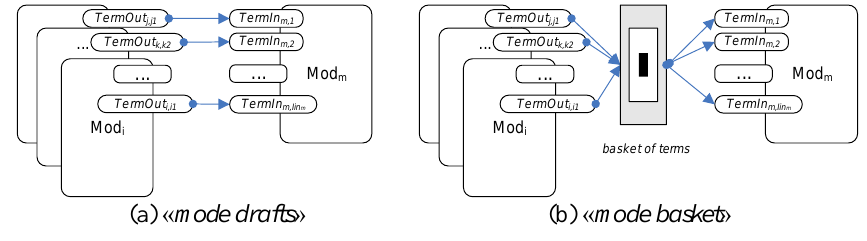
Fig. 2. Modes of term